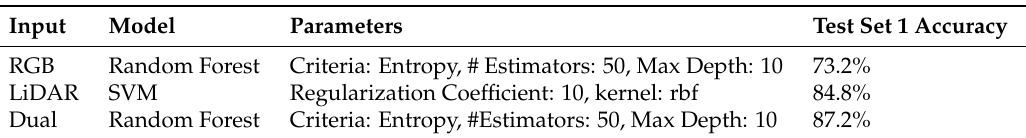
Table 6. Best Classifiers using CNN extracted